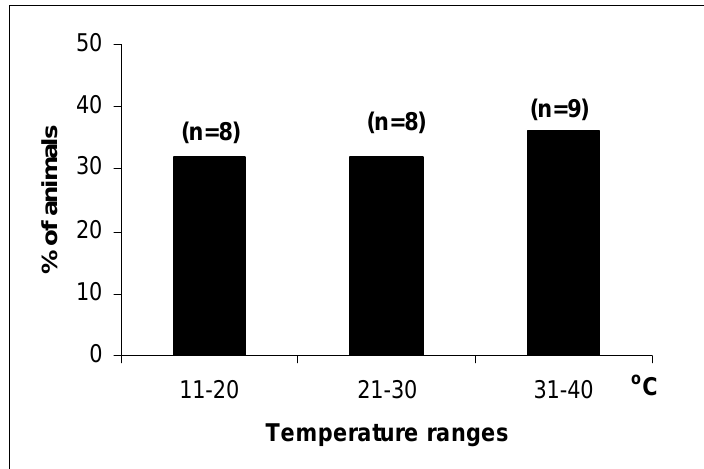
Figure 1. Distribution of yellow scorpion ( Tityus serrulatus ) individuals along the three thermal ranges (from 10°C to 41°C) zones. Differences are not statistically significant according to the Chi-square test (df=2; p